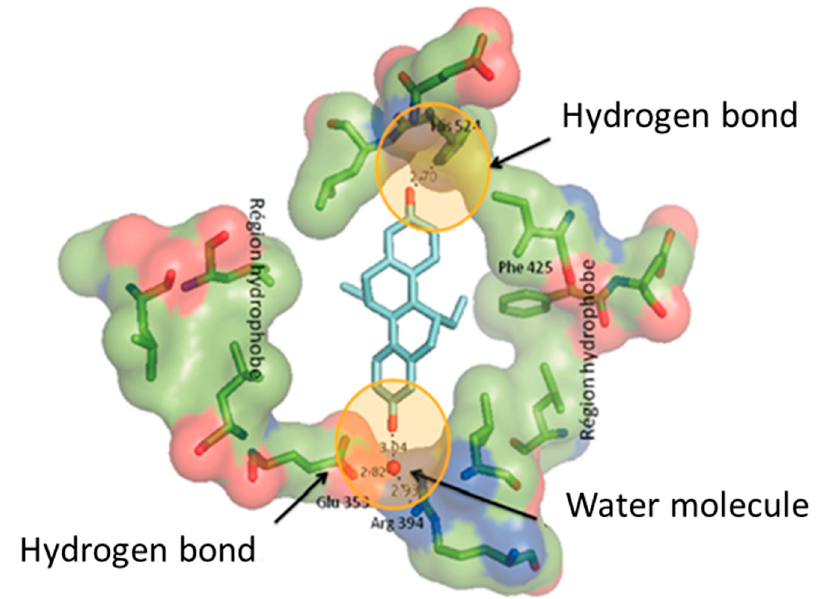
Figure 4. X-ray structure of the hydrophobic pocket of estrogen receptor (ER) α [76], according to the works of Brzozowski et al. [74] and Tanenbaum et al. [75].